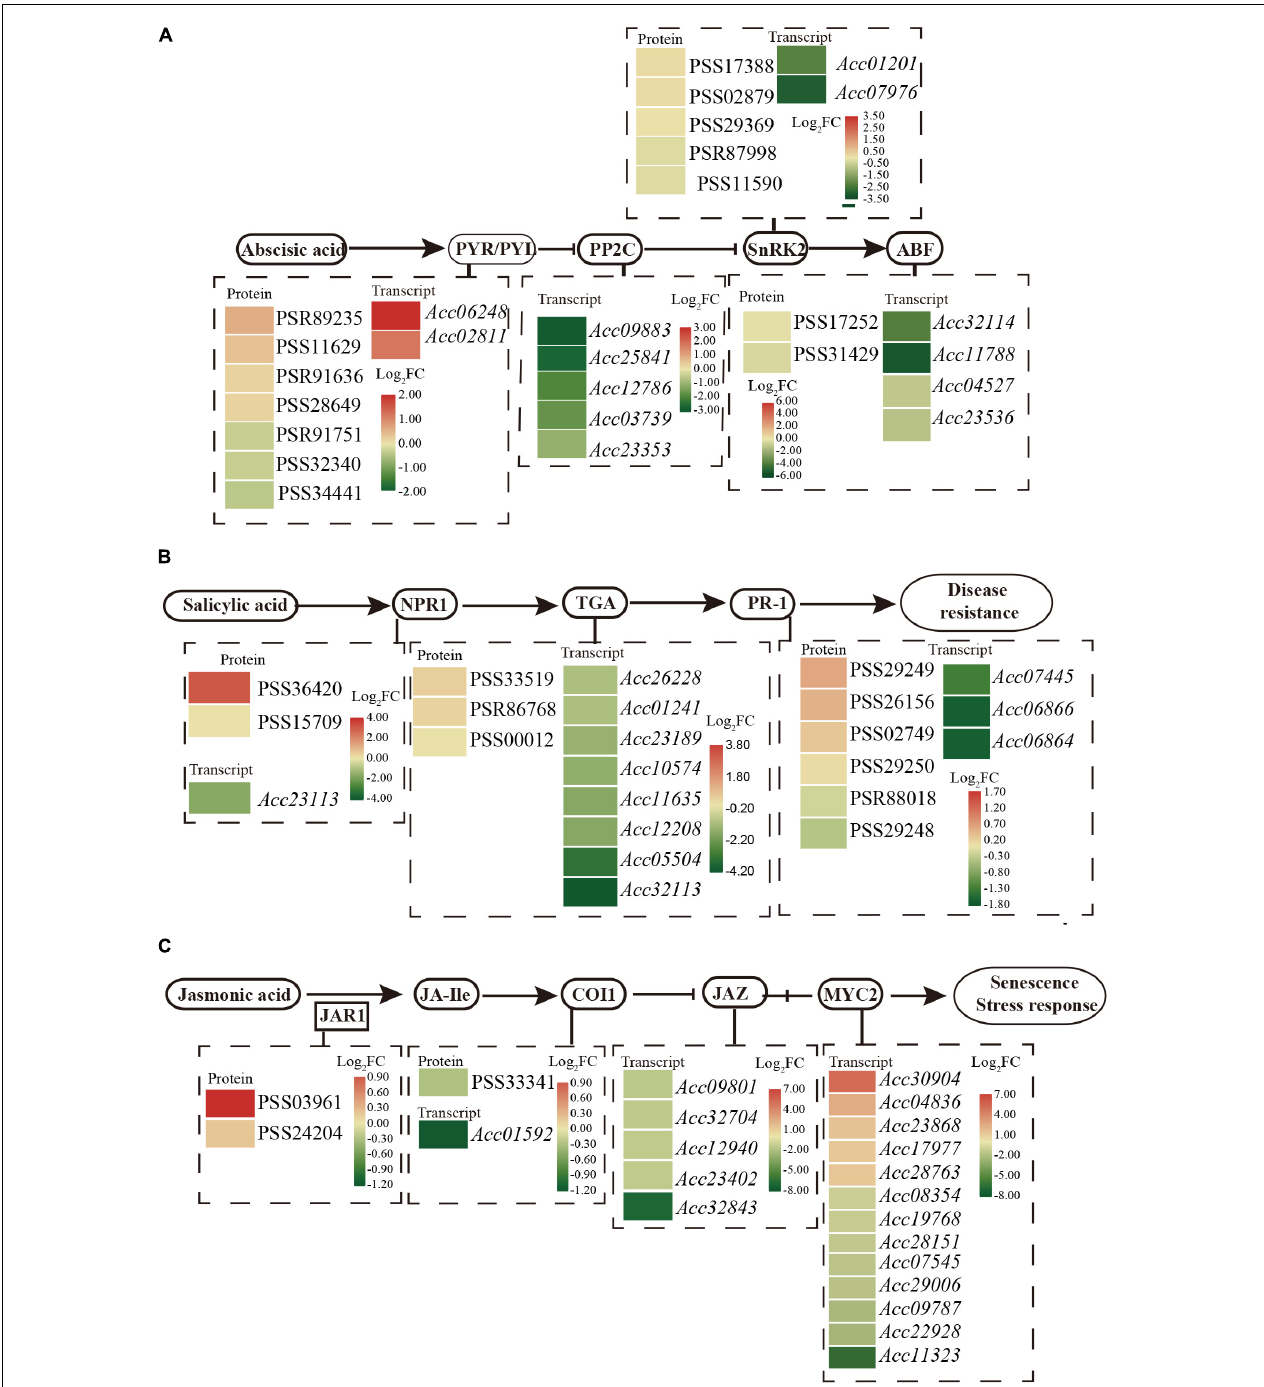
FIGURE 3 | Schematic of the transcriptome and proteome revealed the regulation of ABA (A) , SA (B) , and JA (C) in the plant hormone signal transduction pathway at 1 dpi of Psa in ‘Jinkui’ leaves.